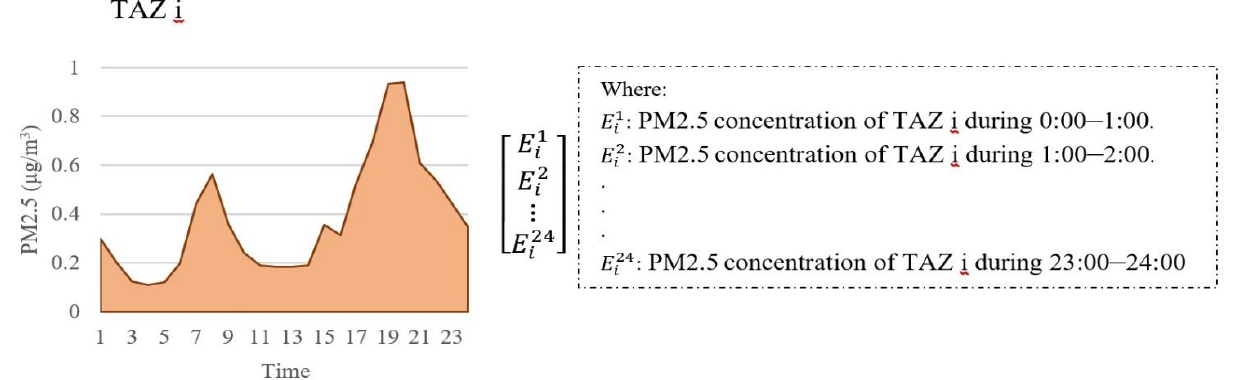
Figure 3. Splitting the work duration of employees into 1-h intervals.